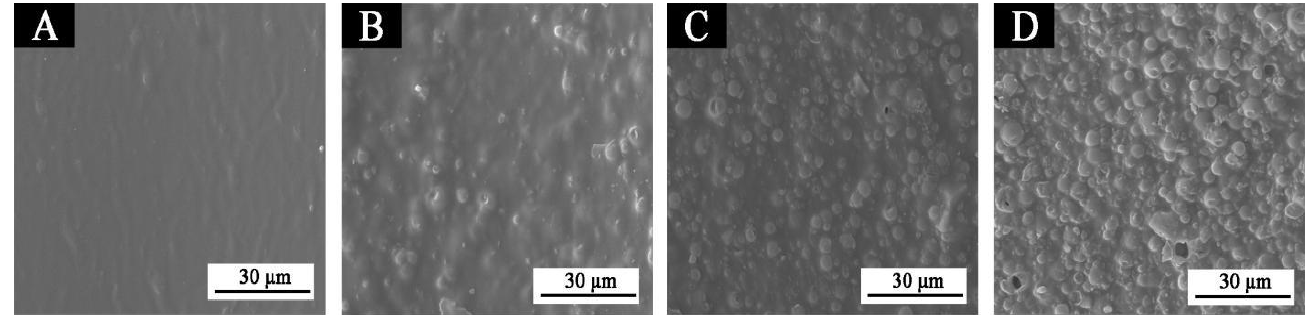
Figure 12. SEM of films with different concentrations of fluorane microcapsules: ( A ) 5#, ( B ) 2#, ( C ) 8#, ( D ) 10#.